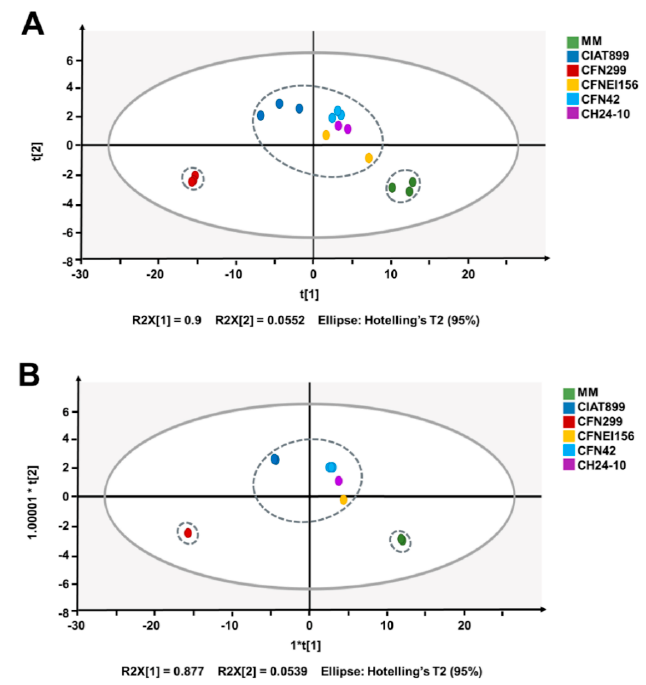
Figure 4. Score plots of ( A ) principal component analysis (PCA) and ( B ) orthogonal partial least squares-discriminant analysis (OPLS-DA) of the 1 H NMR spectra of the five rhizobial strains and MM.